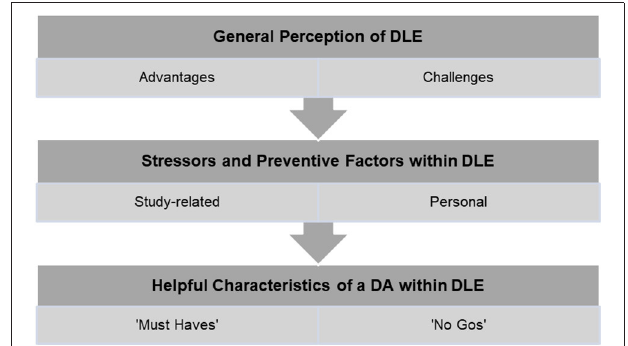
FIGURE 1 | Themes derived from student interviews via SPSS method with according categories.